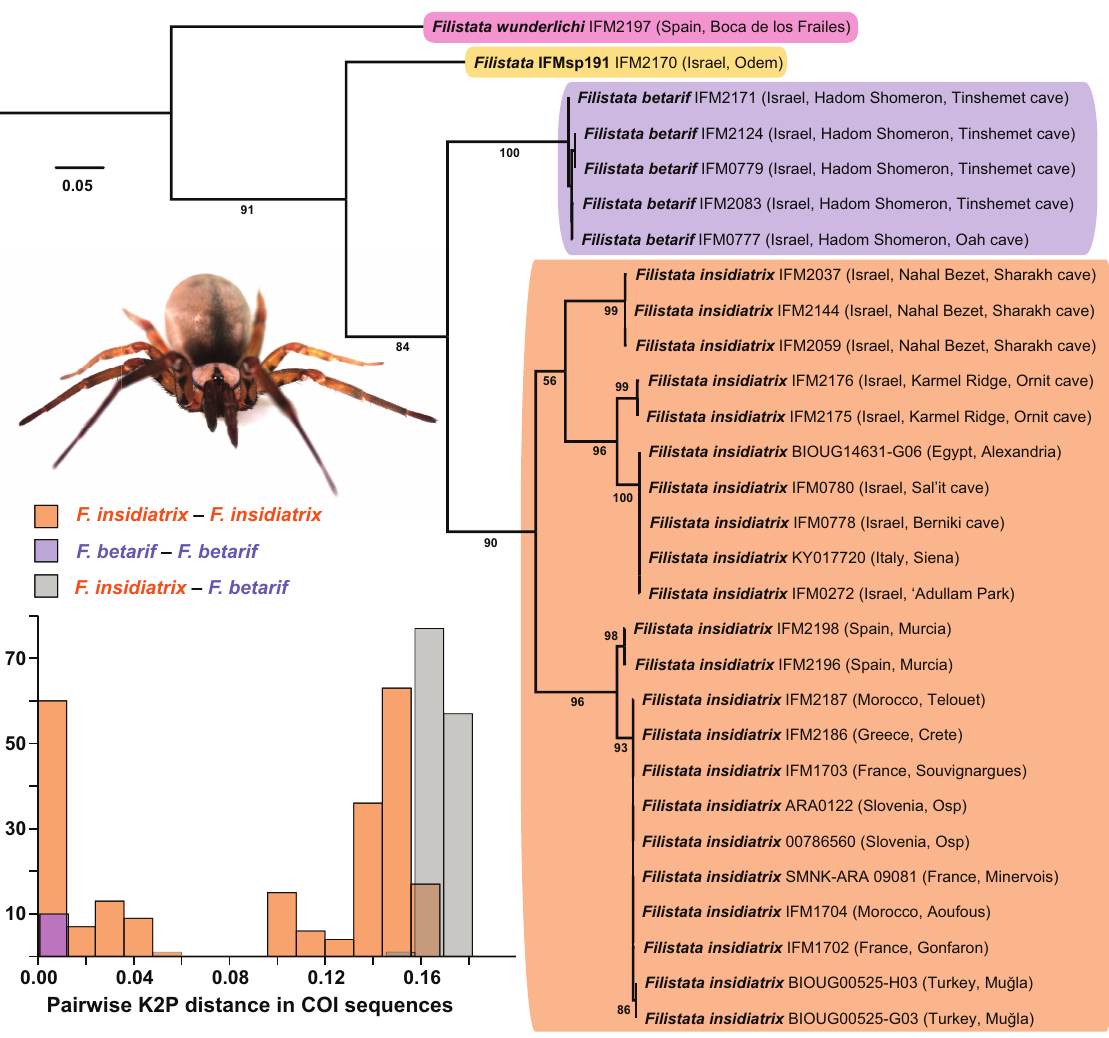
Fig. 2. Phylogenetic tree of cytochrome c oxidase subunit I haplotypes of different species of Filistata Latreille, 1810 inferred under maximum likelihood. Numbers below branches are bootstrap supports. The histogram shows the distribution of pairwise Kimura two-parameter genetic distances within and between F. insidiatrix (Forsskål, 1775) and F. betarif sp. nov. (for pairwise distances of other species, see Table 2). Note that some intraspecific genetic distances within F. insidiatrix are larger than interspecific distances between F. insidiatrix and F. betarif sp. nov., denoting a lack of a barcode gap in this group, or cryptic species within F. insidiatrix